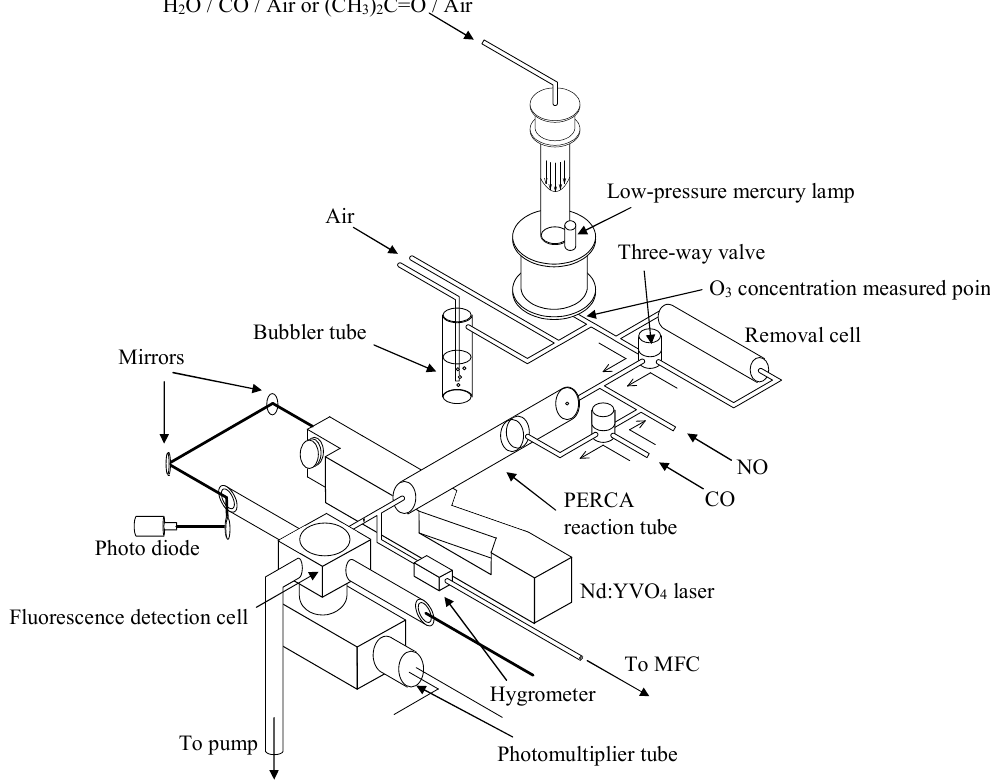
Fig. 1. Schematic diagram of the experiment. The system can be divided into 4 parts, (1) peroxy radical generator, (2) removal cell, (3) chemical amplification reaction tube and (4) LIF NO 2 detector. MFC indicates mass flow